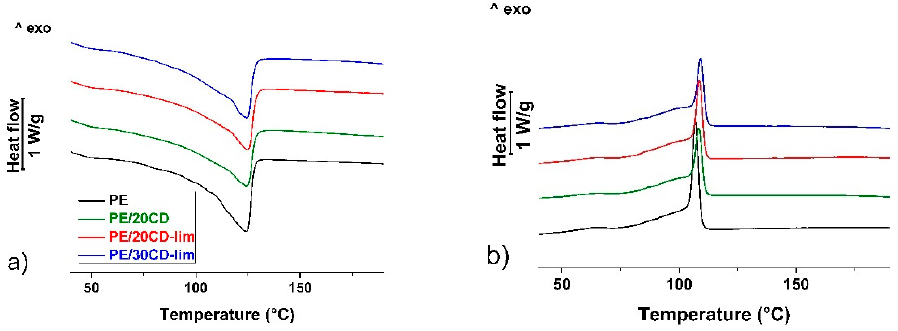
Figure 5. Differential Scanning Calorimetry (DSC). First heating at 10 K min − 1 ( a ) and subsequent cooling at 5 K min − 1 ( b ).